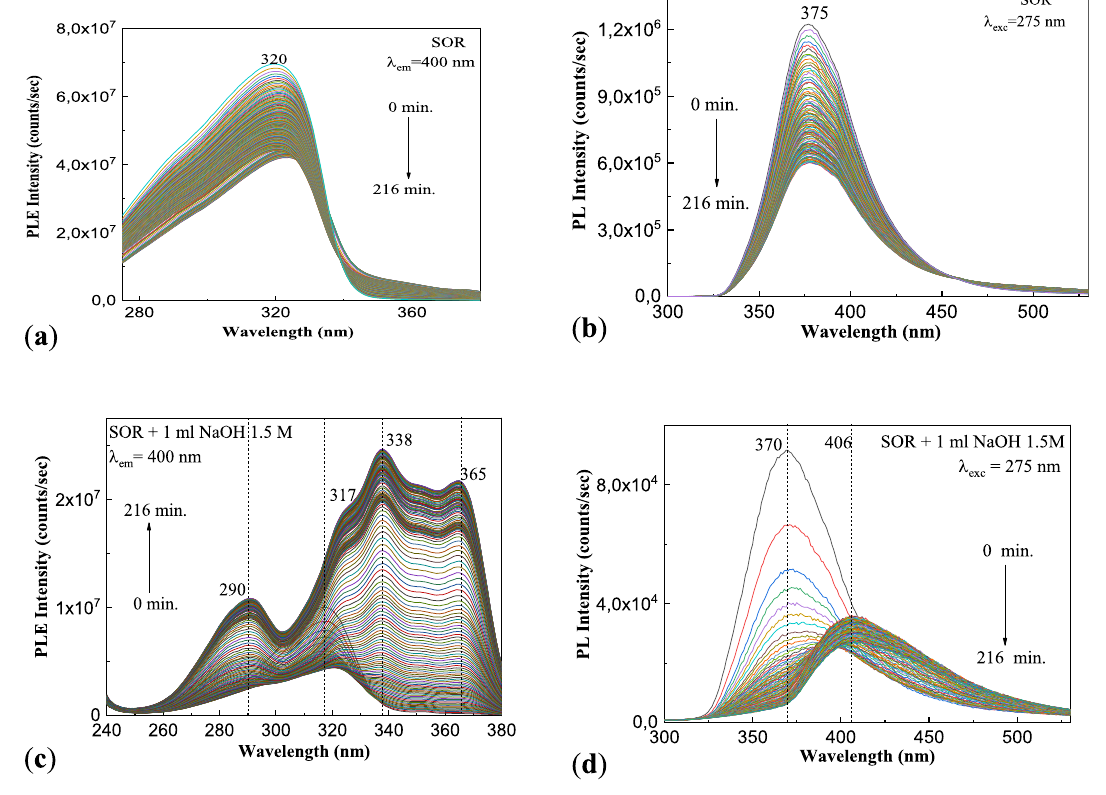
Figure 7. PLE and PL spectra of the aqueous solutions of 3 ml SOR ( a , b ) and 2 ml SOR interacted with 1 ml NaOH 1.5 M ( c , d ) before and after the exposure to UV light for 216